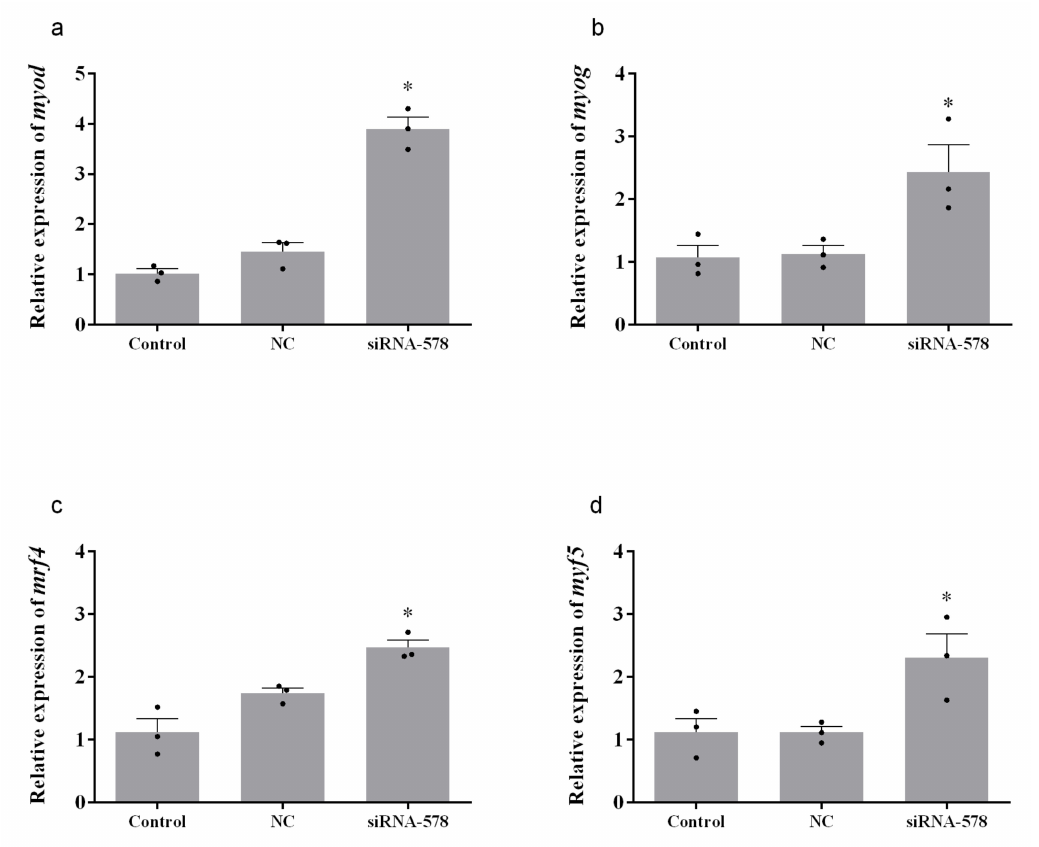
Figure 4. Relative expression of muscle growth-related genes in primary cultured muscle cells treated with si mstn-1 . ( a ) Relative expression of myod . ( b ) Relative expression of myog . ( c ) Relative expression of mrf4 . ( d ) Relative expression of myf5 . Results are represented as mean ± SE ( n = 3). * means significantly di ff erent compared with control ( p <